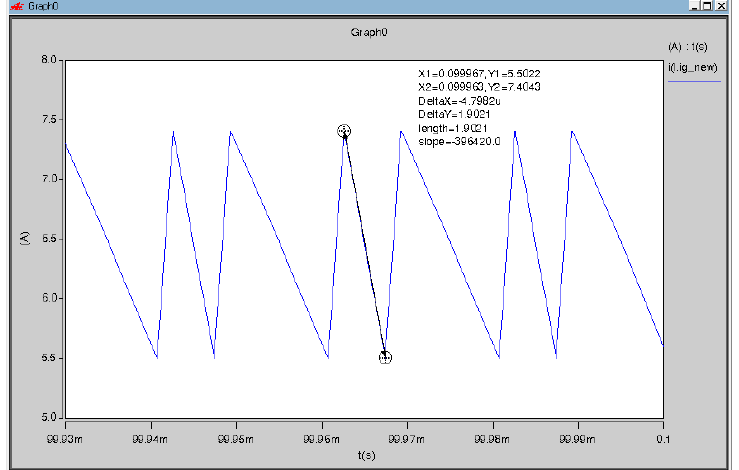
Figure 17. Zoom in the input current ripple for the proposed strategy when G = 5 . 9, D = 0 . 7602 ( k d = 0 . 5612). Case G = 6 . 5, in the former strategy: for the operation point in which the input voltage is 30 . 08 V, the output is 200 V, k L = 0 . 5 (see Table 8); the former strategy would need a duty cycle D = 0 . 7994 ( k d = 0 . 5), which would result in an input current ripple Δ i g = 1 . 1976. Figure 18 shows a zoom in the input current ripple for the former strategy. The point-to-point measure- ment indicates the peak-to-peak current ripple, which is twice of Δ i g . Table 8 indicates 1 . 1976, multiplied by two, would be 2 . 3952; the measurement indicates 2 . 3949.